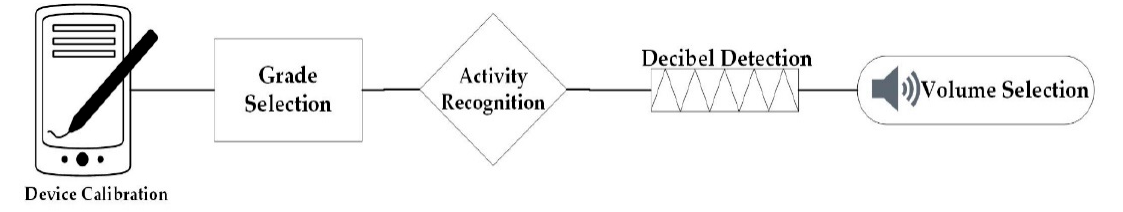
Figure 1. Block diagram for volume control using multisensors.